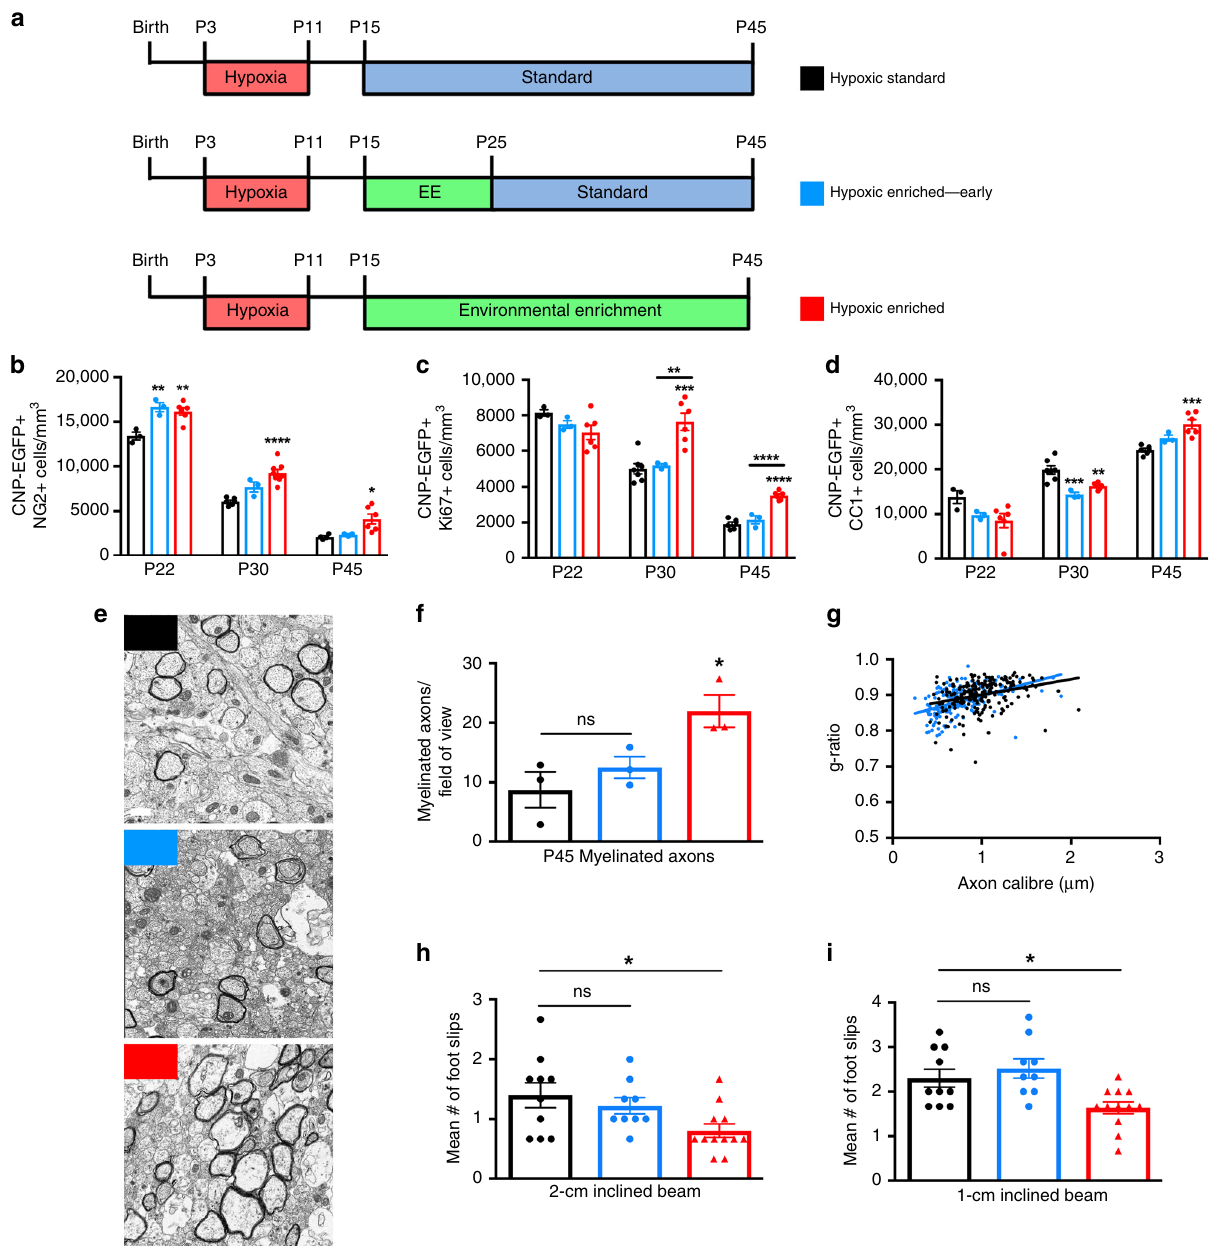
Fig. 5 Continuous environmental enrichment is required for functional white matter recovery after perinatal brain injury. a Experimental paradigms. b Quanti fi cation of EGFP + NG2 + OPCs (P22: HX, n = 3; HX-EE early, n = 3; HX-EE continuous, n = 6; P30: HX, n = 6; HX-EE early, n = 3; HX-EE continuous, n = 8; P45: HX, n = 4; HX-EE early, n = 3; HX-EE continuous, n = 6) (from left to right: ** p = 0.006, ** p = 0.007, **** p < 0.0001, * p = 0.023). c Quanti fi cation of EGFP + Ki67 + OPCs (at P22: HX, n = 3; HX-EE early, n = 3; HX-EE continuous, n = 6; at P30: HX, n = 7; HX-EE early, n = 3; HX-EE continuous, n = 6; at P45: HX, n = 6; HX-EE early, n = 3; HX-EE continuous, n = 6) (** p = 0.005, *** p = 0.0004, **** p < 0.0001). d Quanti fi cation